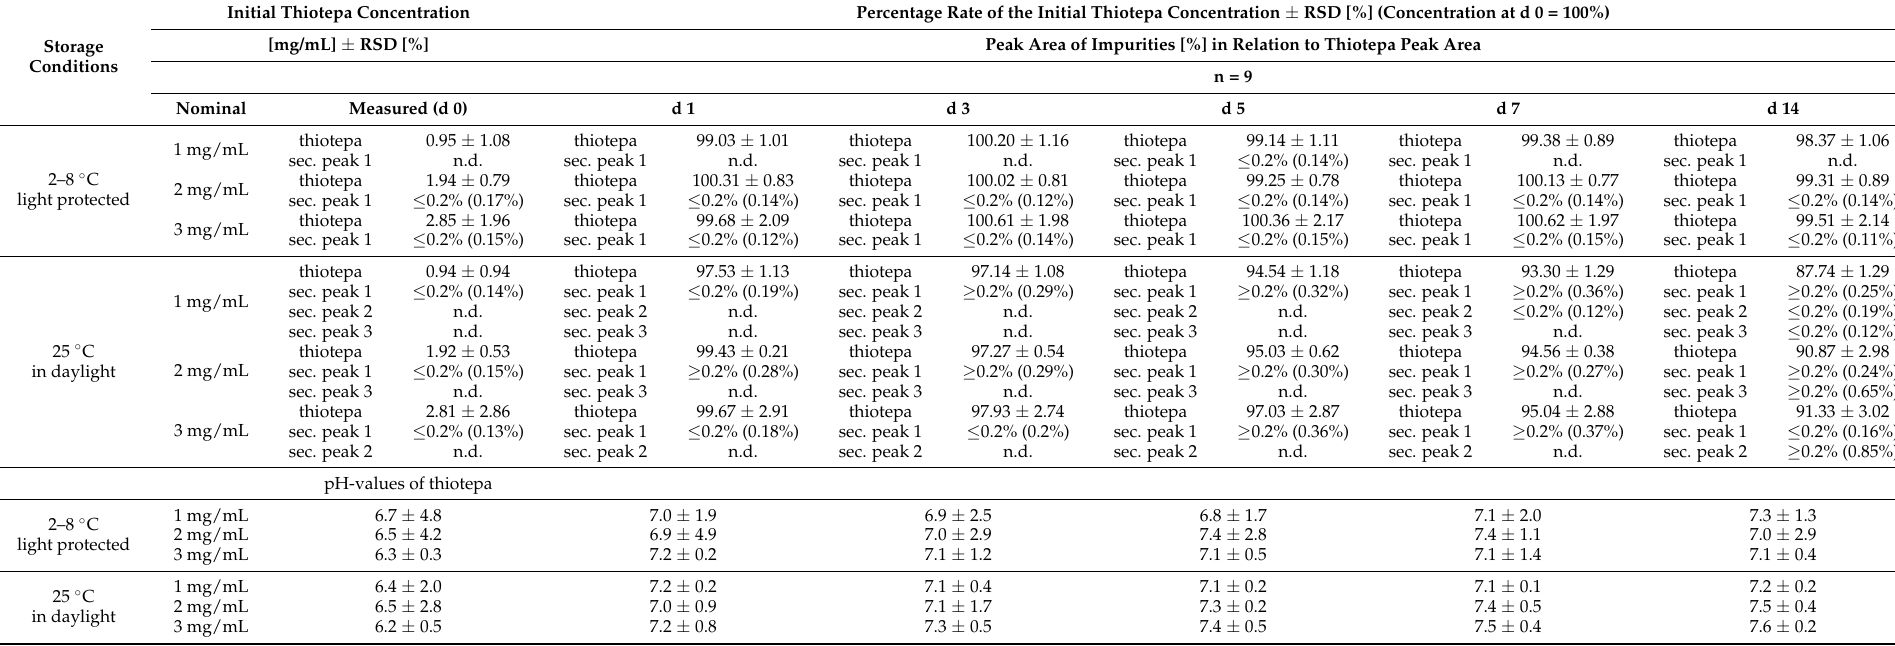
Table 3. Thiotepa concentration, peak areas of secondary peaks and pH of thiotepa infusion solutions (1 mg/mL, 2 mg/mL, 3 mg/mL) diluted in glucose 5% carrier solution stored under two different conditions for 14